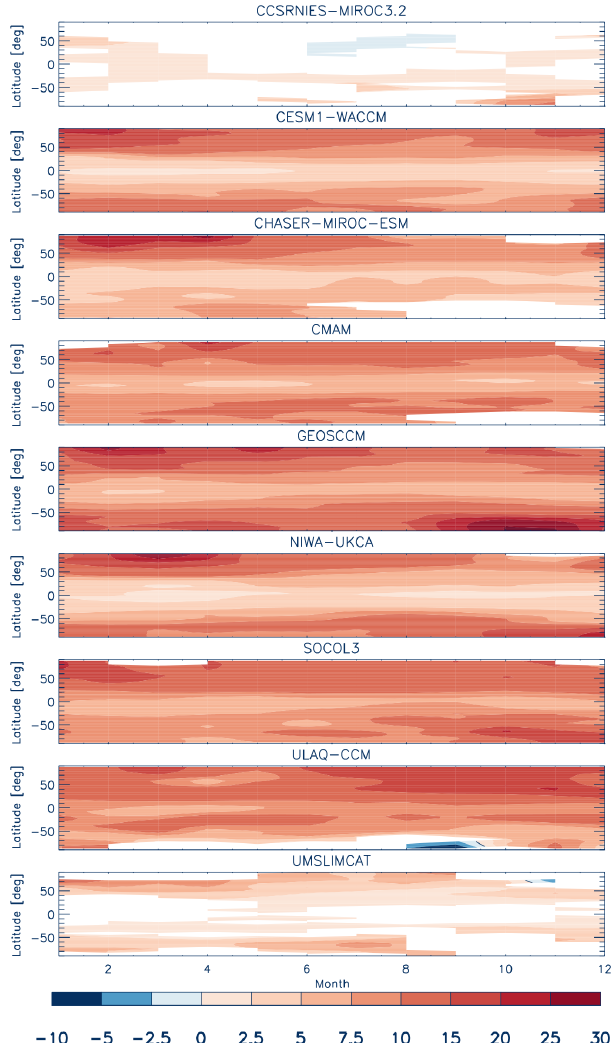
Figure 2. Ratio of zonal-mean total-column ozone changes to VMR changes in surface CH 4 (in Dobson units ppmv − 1 ) as derived from the REF-C2 and SEN-C2-fCH4 simulations. The colour white indi- cates insignificantly differences from 0 at the 95% confidence in- terval.